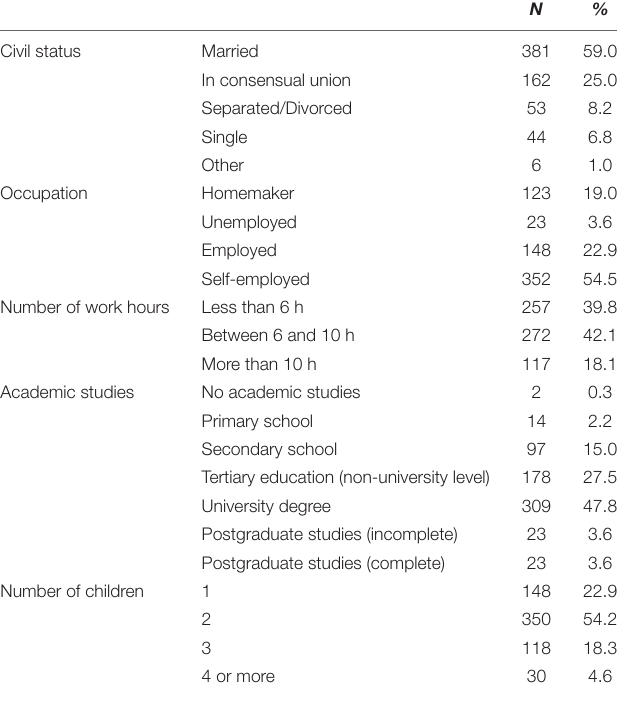
TABLE 1 | Demographic and work-related characteristics of the